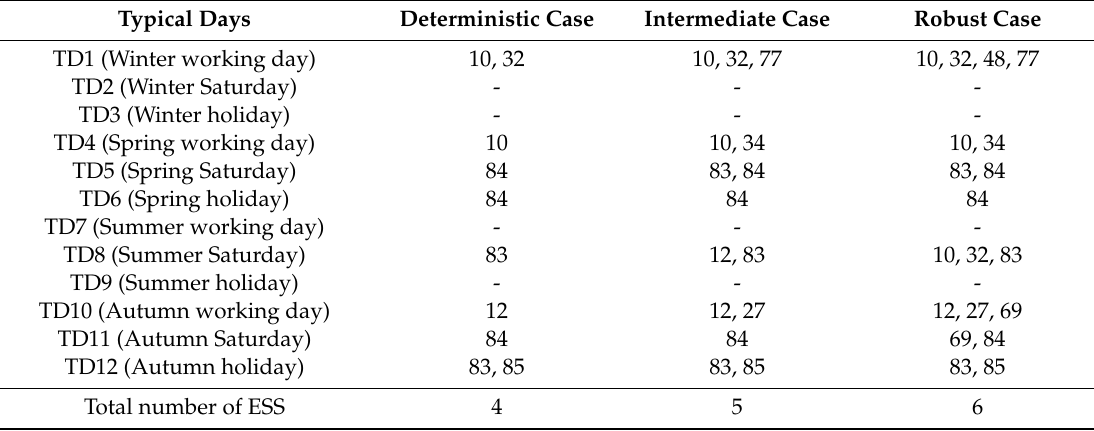
Table 1. Storage placement for each typical day for the three considered